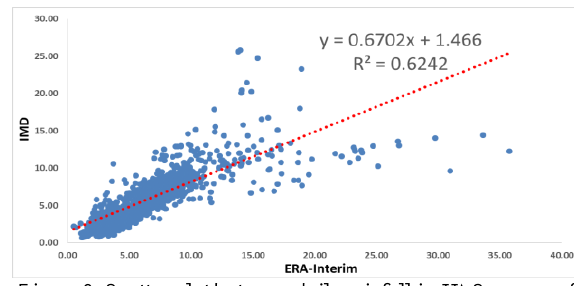
Figure 9. Bias in daily rainfall between Era-Interim and [a] IMD [b] APHRODITE Products for the season JJAS